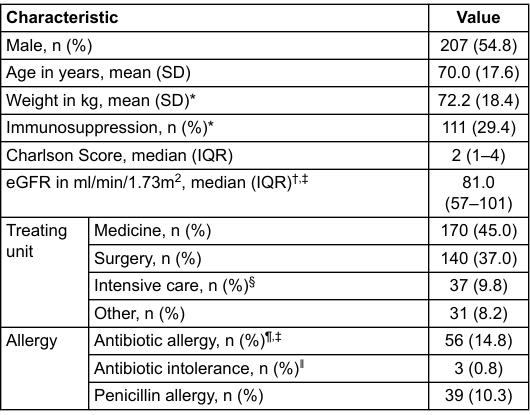
Table 1: Patient characteristics (n = 378).